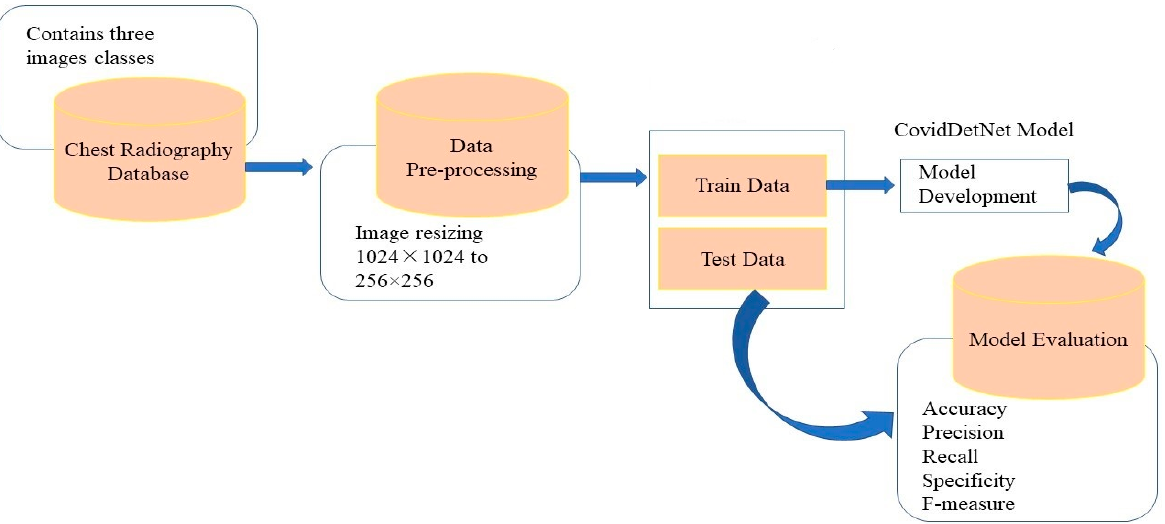
Figure 1. Abstract view of proposed CovidDetNet framework.